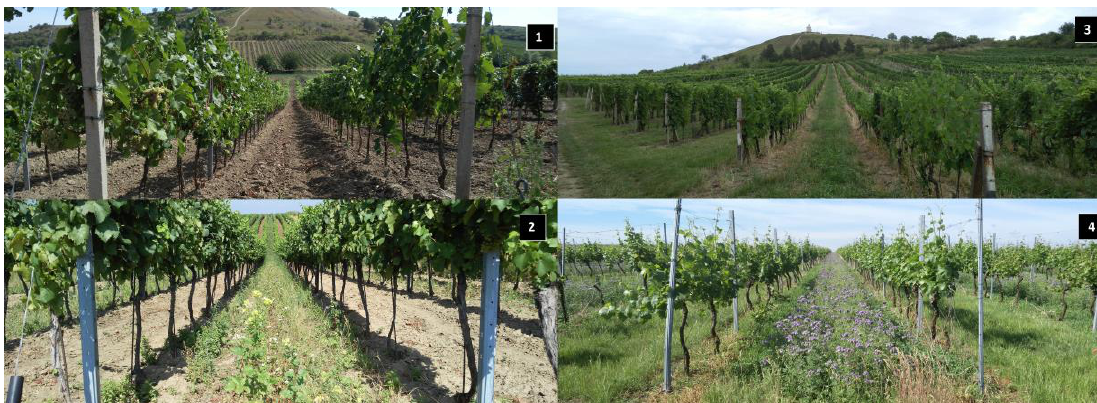
Figure 2. Examples of vineyard floor management: ( 1 ) Total area bare soil (BS) (V. Bílovice, 2017), ( 2 ) Alternate greening with commercial plant mixture (variant A) (V. Bílovice, 2017), ( 3 ) Full-area cover crop with 90% of grass species in mixture (variant B) (V. Bílovice, 2017), ( 4 ) Full-area cover crop with combination of grass covered rows and commercial plant mixture (variant A + B) (Valtice, 2017) (Photography: L. Ragasová).